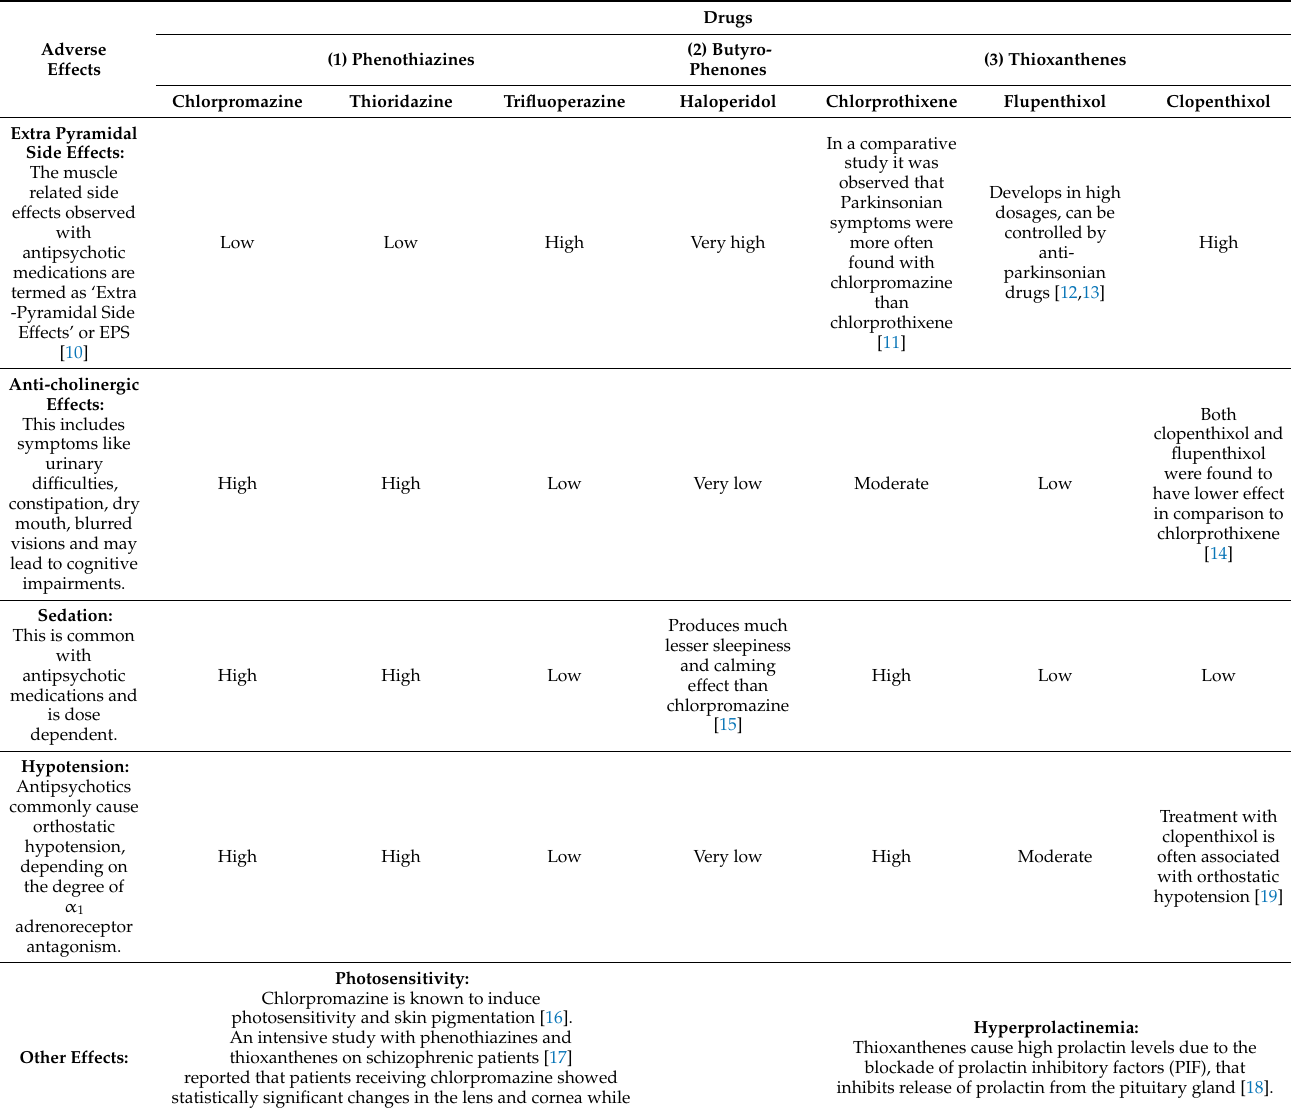
Table 2. Comparative summary of antipsychotic side